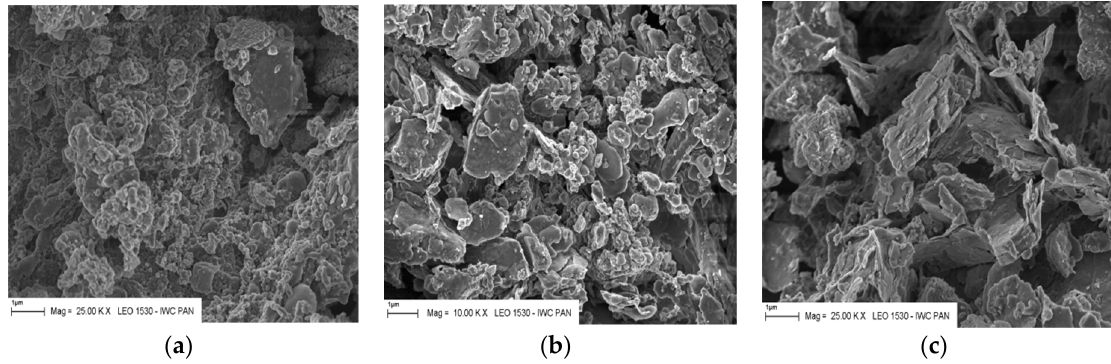
Figure 1. Microstructure of CFBC ashes from different power stations: ( a ) T, lignite burning; ( b ) S, hard coal burning; and ( c ) K, hard coal burning. Magnification 25,000×, scale bar = 1 μ m.